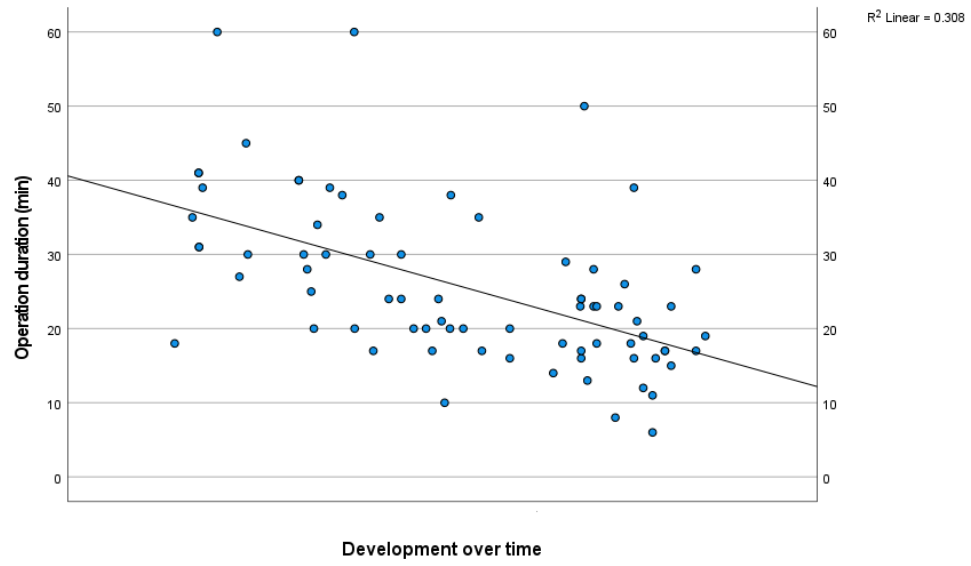
Figure 4. Development of operation duration (minutes) over